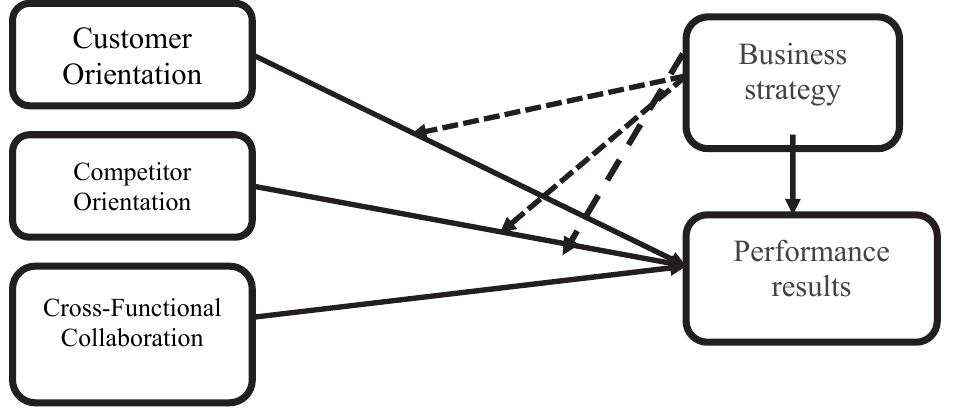
Fig. 1. Research model of the impact of business strategy, market orientation on business performance